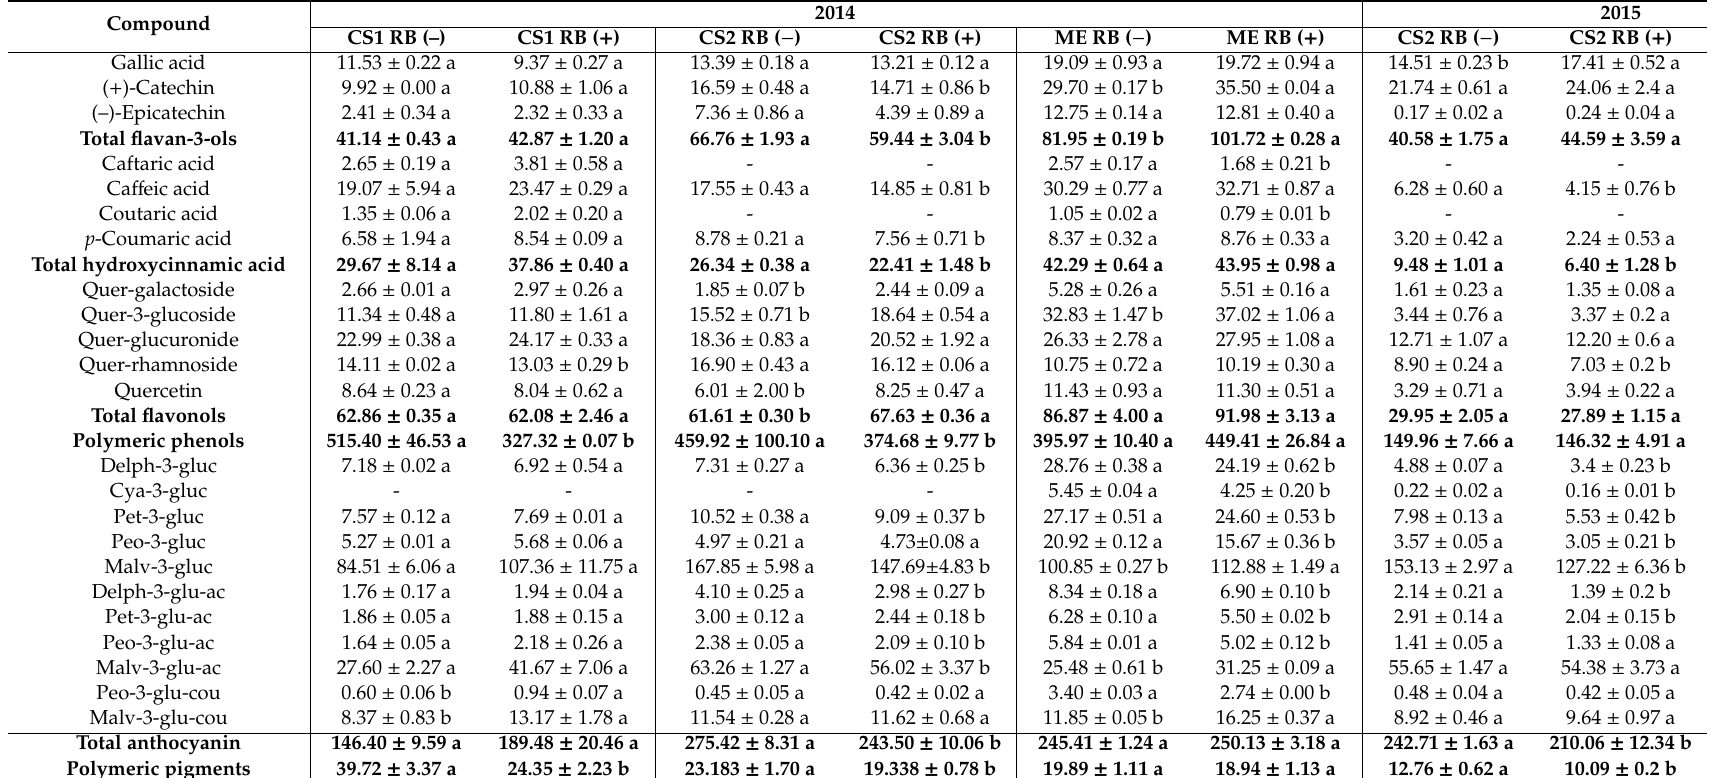
Table 3. Phenolic profiles of RB ( − ) and RB ( + ) wines over two